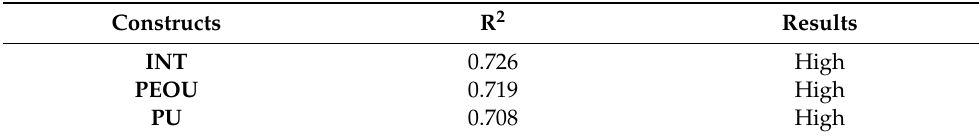
Figure 2. Hypotheses’ testing results. * p < 0.05, ** p < 0.01. Table 8. R 2 of the endogenous latent variables.